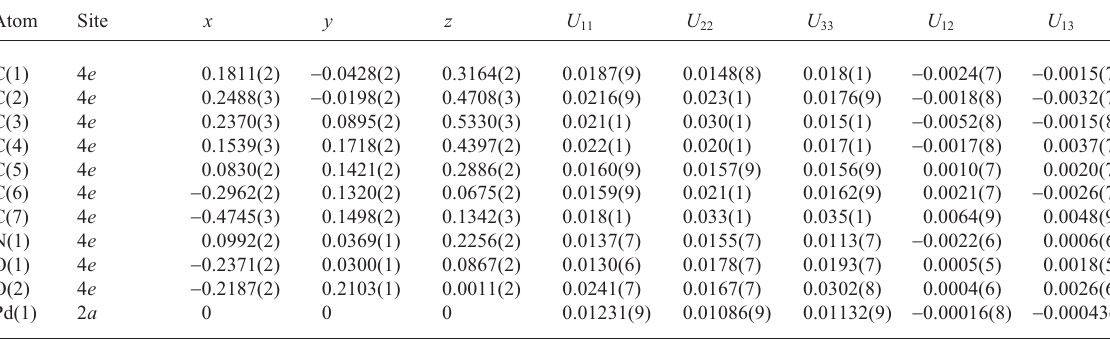
Table 3. Atomic coordinates and anisotropic displacement parameters (in Å 2 )